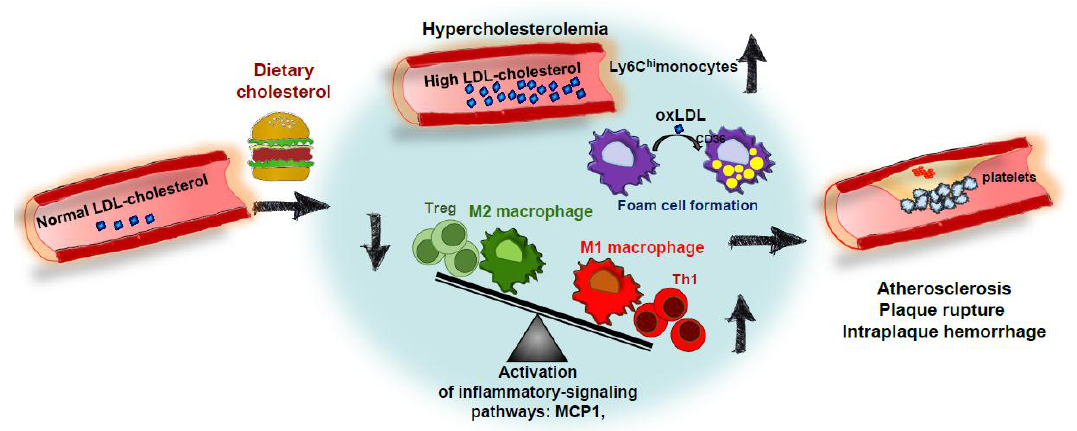
Figure 2. Impact of dietary cholesterol on atherosclerosis. High circulating cholesterol levels (mostly cholesterol carried by LDL-C particles) are the main risk factor for developing atherosclerosis. Under certain conditions, dietary cholesterol induces hypercholesterolemia and enhanced levels of proinflammatory Ly6C hi monocytes. This might facilitate macrophage foam cell formation through the uptake of modified LDL particles by scavenger receptors (CD36). Atherosclerosis development involves an imbalance between M1 macrophages/M2 macrophages and Th1/Treg cells which can be facilitated by hypercholesterolemia. These events lead to the activation of inflammatory pathways and the progression of disease toward more advanced plaques and, in some cases, plaque rupture, intraplaque hemorrhage, and thrombosis. LDL-C: low-density lipoprotein cholesterol